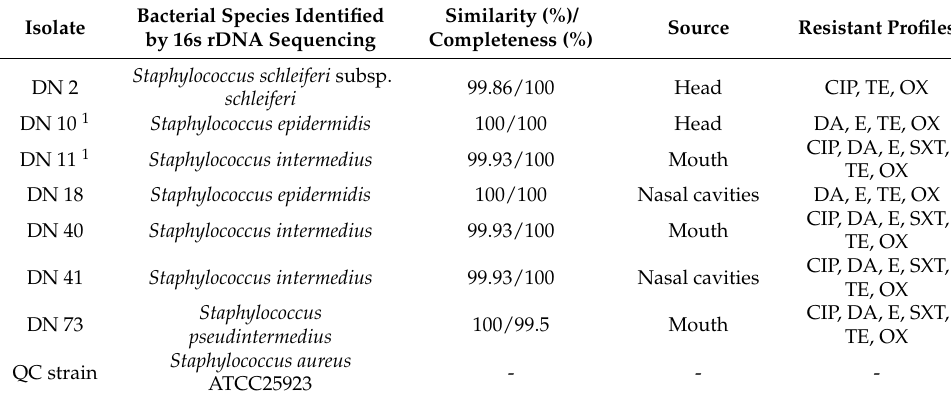
Table 1. Information about the isolates and their resistance profiles. Bacterial Species Identified Isolate by 16s rDNA